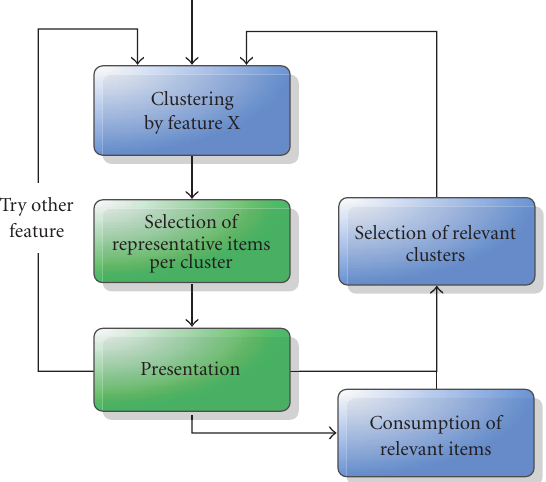
Figure 1: The basic workflow of the video browsing